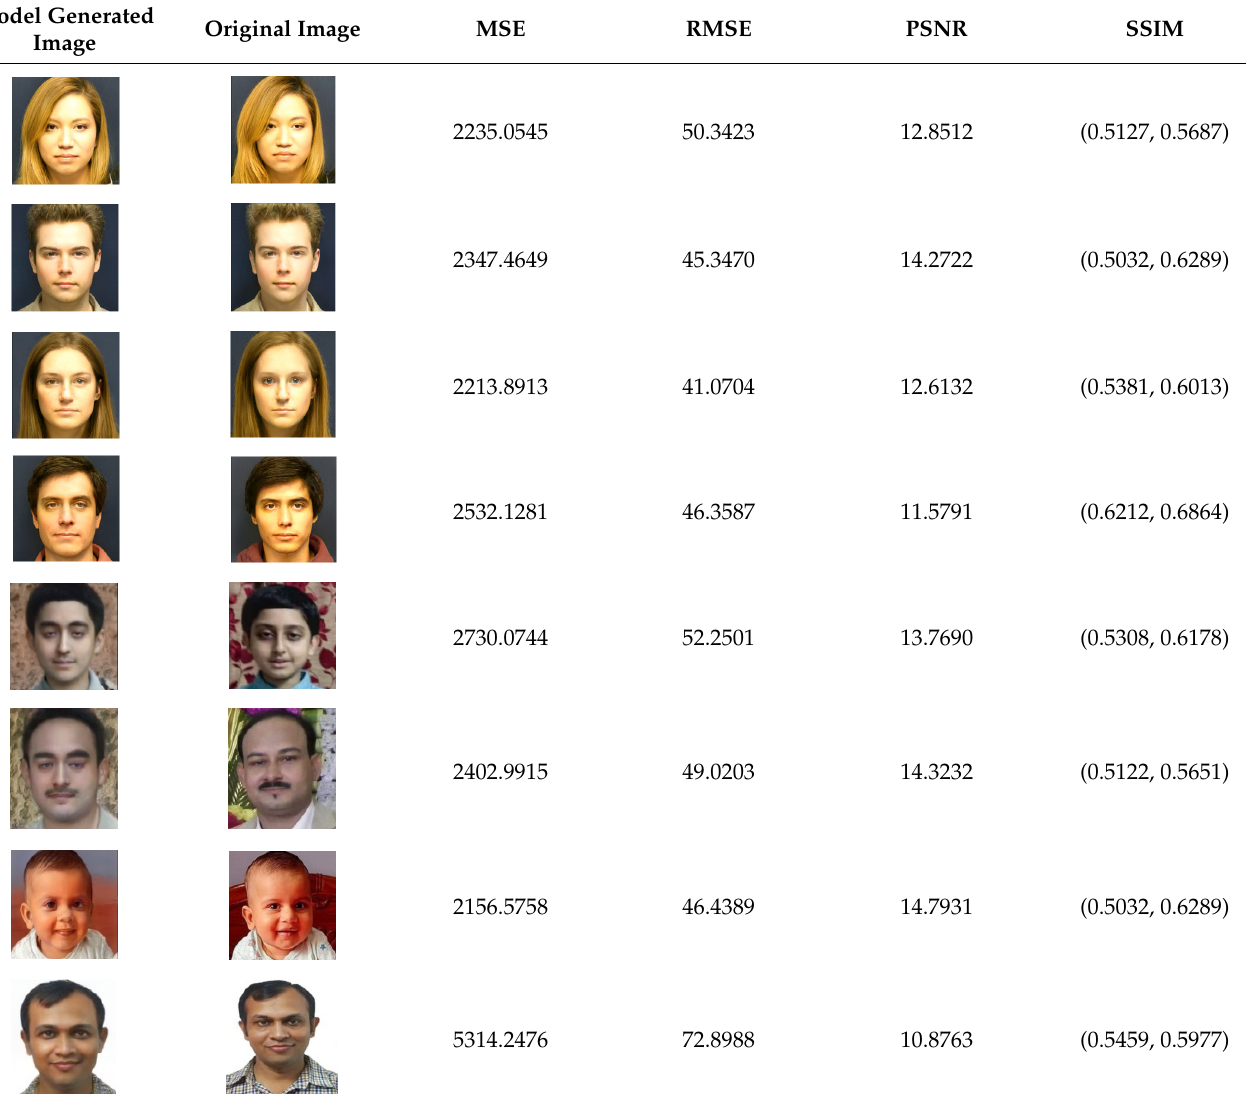
Table 2. MSE, RMSE, PSNR, and SSIM evaluation on sample images.